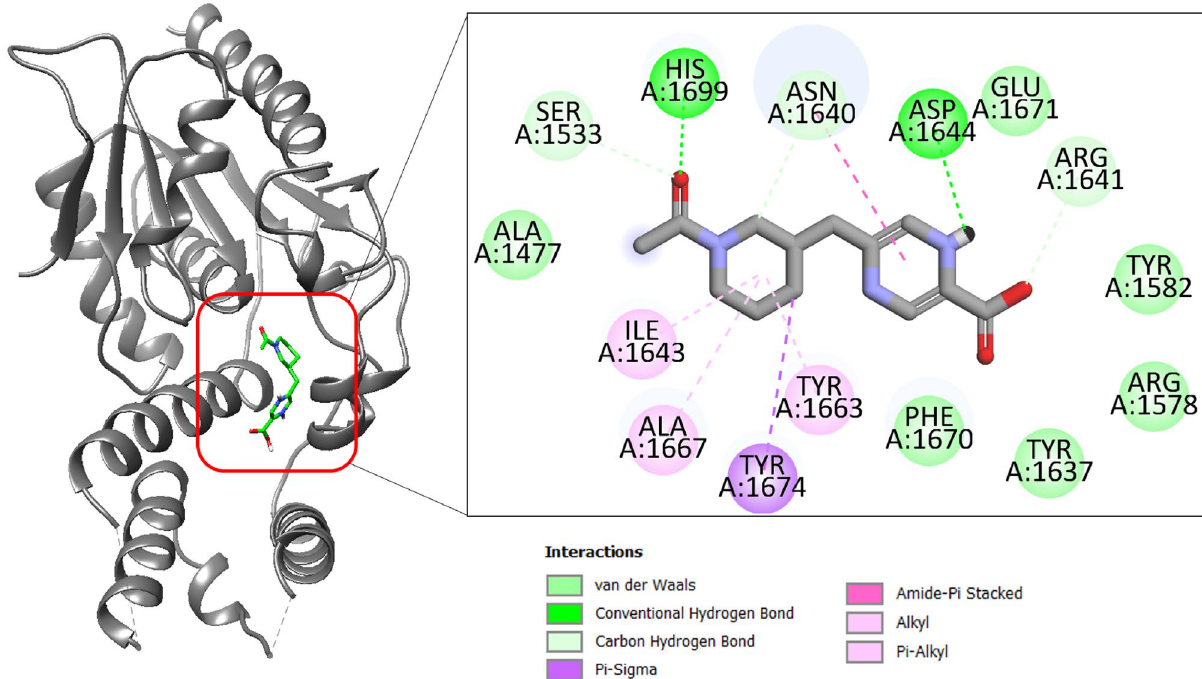
Figure 1. Binding mode of compound BBB_26582140 at the active pocket of polyketide synthase Pks13. The receptor enzyme is given in gray cartoon while the compound is presented in green stick. The binding interactions network is also provided.